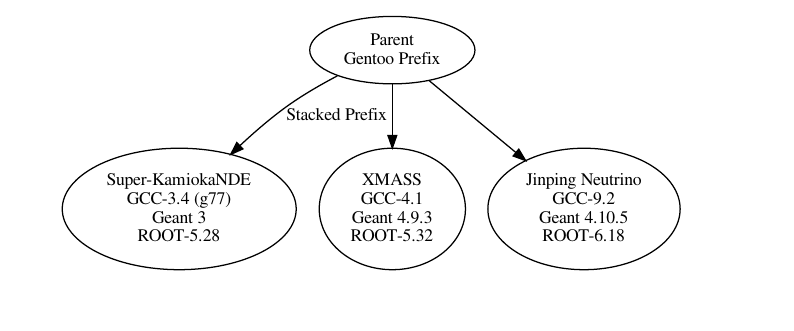
Figure 4. Legacy software stacks of experimental physics are managed by stacked Prefix, to give maximal flexibility while avoiding code duplication using the parent Prefix.